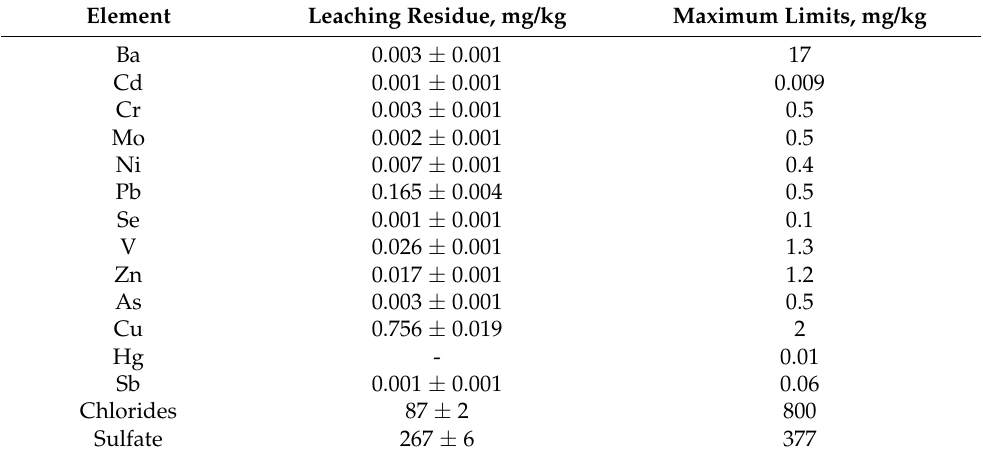
Table 5. Concentrations of contaminants in the leachate of the leaching residue compared to regula- tory maximum